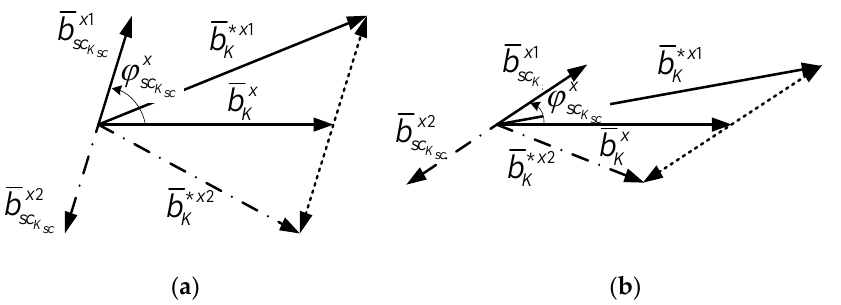
Figure 7. Phasor diagram variation ( a ) no loaded condition ( b ) loaded condition.